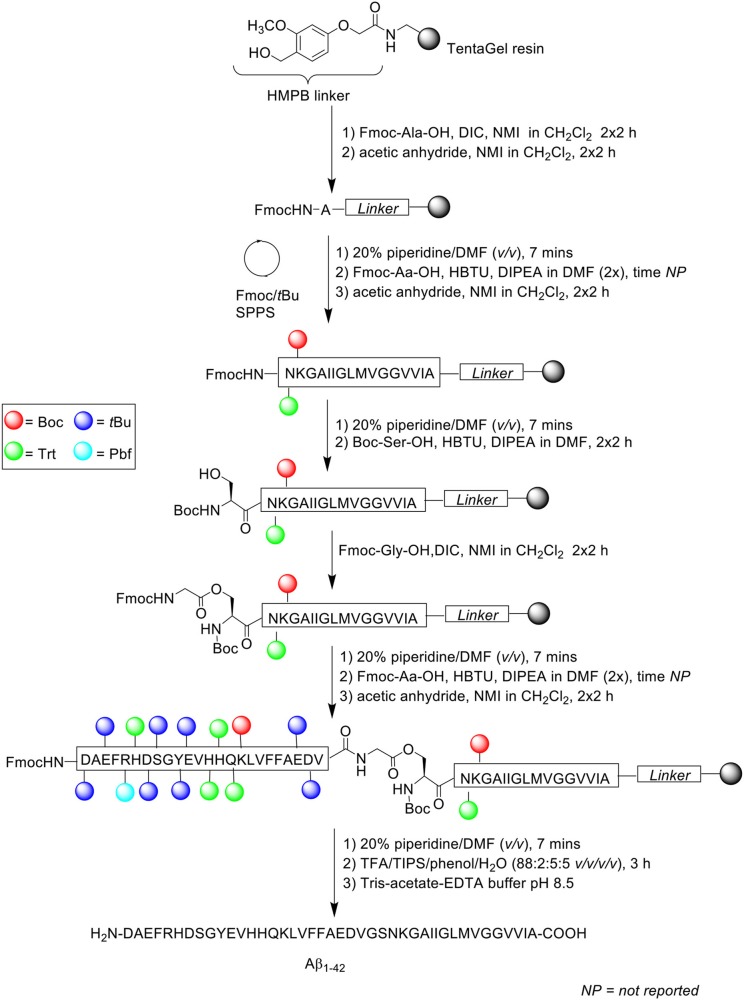
Fmoc/tBu SPPS of Aβ1−42 using depsipeptide methodology by Carpino et al. (2004).